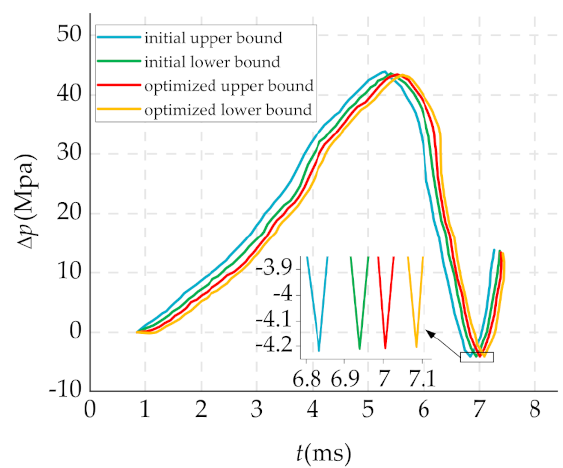
Figure 24. The initial and optimized interval of pressure wave of the propellant